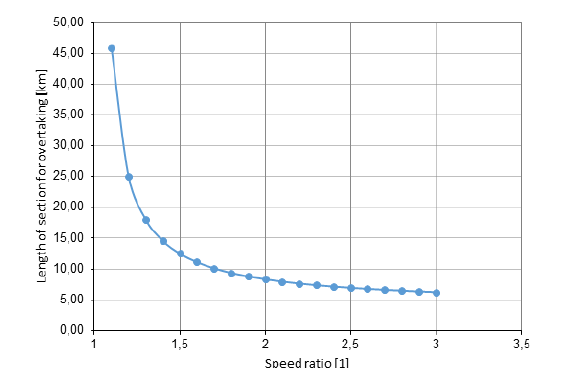
Figure 3. Relationship between speed ration and Length of section for overtaking.